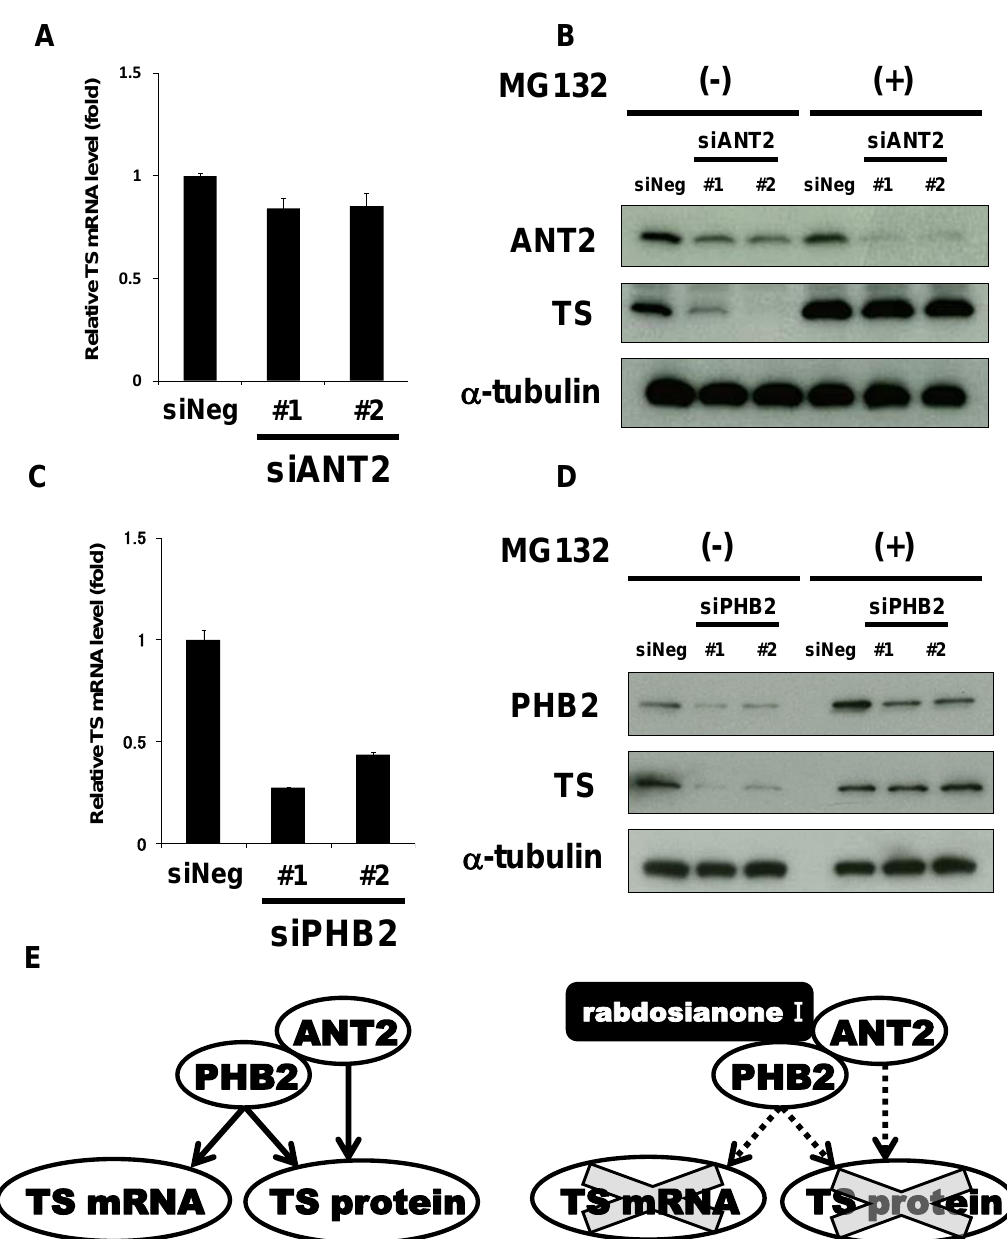
Figure 6. ANT2 and PHB2 may prevent proteasomal degradation of TS protein, whereas PHB2 may also increase TS mRNA expression. ( A ) Effects of ANT2 depletion on TS mRNA expression. The expression of TS mRNA was measured by quantitative PCR in HT-29 cells treated with siANT2 or siNeg for 48 h. TS mRNA was normalized to GAPDH mRNA, and the results with siNeg were taken as 1. Columns, means ( n = 3); bars, SD. ( B ) Effects of ANT2 depletion on TS protein expression with or without MG132 treatment. HT-29 cells were treated with siANT2 or siNeg for 24 h, and the medium was then replaced with that containing 10 µ M MG132 or DMSO. After incubation for 24 h, ANT2 and TS were analyzed by Western blotting. α -Tubulin was used as a loading control. ( C ) Effects of PHB2 depletion on TS mRNA expression. The expression of TS mRNA was measured by quantitative PCR in HT-29 cells treated with siPHB2 or siNeg for 48 h. TS mRNA was normalized to GAPDH mRNA, and the results with siNeg were taken as 1. Columns, means ( n = 3); bars, SD. ( D ) Effects of PHB2 depletion on TS protein expression with or without MG132. HT-29 cells were treated with siPHB2 or siNeg for 24 h, and the medium was then replaced with that containing 10 µ M MG132 or DMSO. After incubation for 24 h, PHB2 and TS were analyzed by Western blotting. α -Tubulin was used as a loading control. ( E ) Schematic representation of the pleiotropic regulation of TS by ANT2 and PHB2. ANT2 and PHB2 may stabilize TS at the protein level, whereas PHB2 may also increase TS mRNA expression (e.g., promoting transcription). Rabdosianone I binding to ANT2 and PHB2 may promote proteasomal degradation of TS protein, whereas its binding to PHB2 may suppress TS